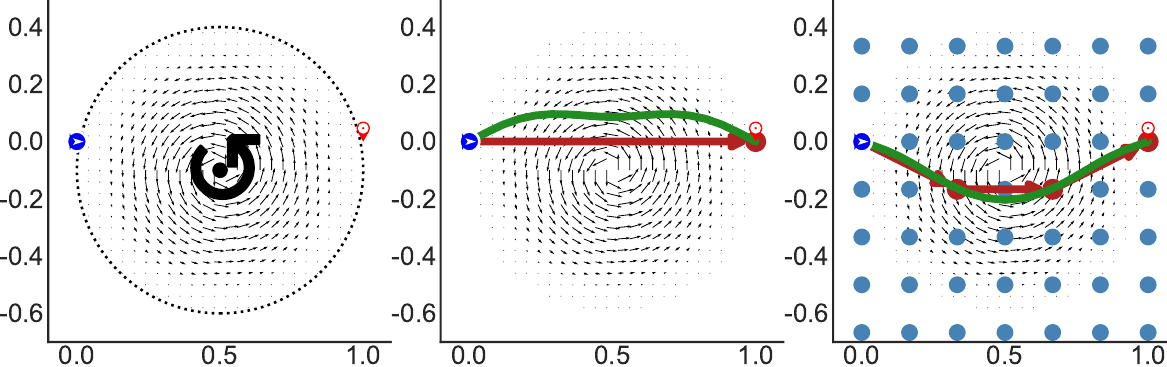
Figure 3. Test problem (b) with counterclockwise spinning vortex centered at z = [ 0.5, − 0.1 ] T , R = 0.5. x O = [ 0,0 ] T , x D = [ 1,0 ] T , ¯ w = 1 ¯ v . Blue dots: network graph with h = l 2 and 1/ h x = 1 and 6, respectively, red: discrete optimal 2 trajectory, green: continuous optimal